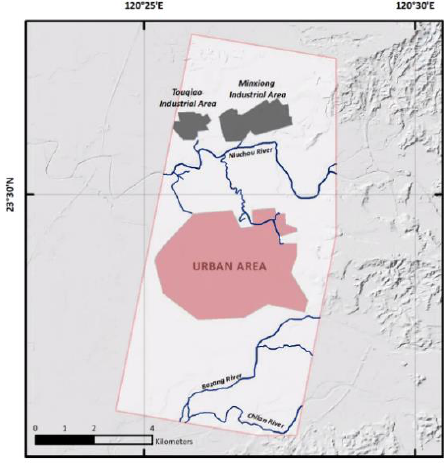
Figure 1. Test Site: Chiayi City of